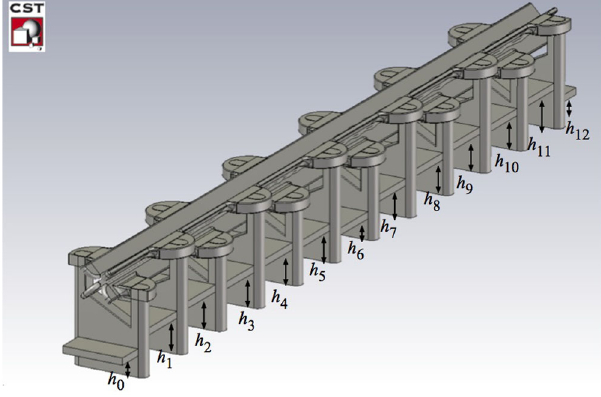
FIG. 7 (color online). This is a view of the FNAL RFQ that shows the tuning plates at arbitrary heights h n